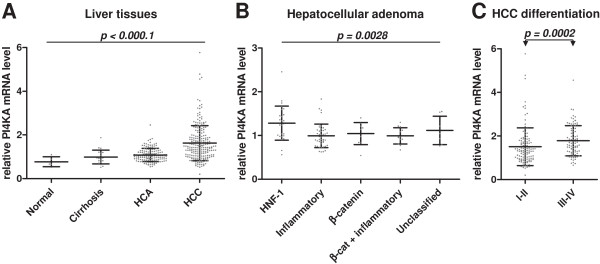
PI4KA transcript abundance in human liver samples of various subtypes. Scatter plots show the PI4KA mRNA levels in human liver tissues as assayed by RT-real time PCR. Values represent the gene expression of each sample relative to the mean value for two control samples from normal hepatic tissues. The 18S RNA levels were used for normalization. Means with standard deviations are indicated for each sample category. P values from Kruskal-Wallis tests (more than two groups, panels A and B; black line) or Mann–Whitney U-tests (two groups, panel C; black line with arrows) are indicated. (A) Comparison between normal hepatic tissue (n = 5), cirrhotic tissue (n = 21), and benign (HCA, n = 101) and malignant (HCC, n = 217) hepatocellular tumors. (B) Expression in different hepatocellular adenoma (HCA) groups subdivided into adenomas inactivated for HNF1A (n = 27), inflammatory adenomas (n = 44), β-catenin-activated adenomas (n = 10), inflammatory and β-catenin-activated adenomas (n = 13) and unclassified adenomas (n = 7). (C) Expression compared according to the differentiation grade of HCC grouped according to the Edmonson classification (Grades I-II, n = 118; Grades III-IV, n = 88).